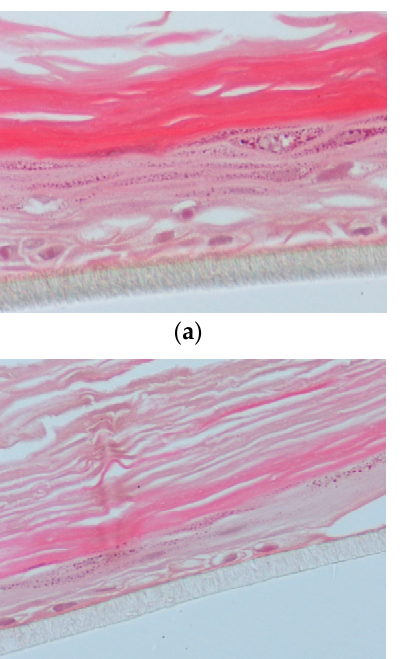
Figure 7. Propolis extracts decrease the mRNA levels of MMPs after UVB irradiation in a reconstituted human skin model. Epiderm TM EPI-200 human skin tissues were pretreated with 20 μ g/mL of either PR_1b ( a ) or PR_9b ( b ), for 2 h prior to UVB irradiation (55 mJ/cm 2 ) and incubated again with or without the propolis extracts for 2 h. After 24 h, the tissues were harvested, and total RNA was extracted. Quantitative real-time PCR was utilized to determine levels of MMP-1, -3, -7, and -9 mRNA. Expression levels of MMP-1, -3, -7, and -9 were normalized to those of β -actin . Untreated cells served as a reference sample. The formula RQ = 2 −ΔΔ Ct was used in order to quantitate the data. The graph is representative of three independent experiments performed in triplicate. * p ≤ 0.05, ** p ≤ 0.01, *** p ≤ 0.001, **** p ≤ 0.0001. To further validate the effect of propolis extracts on the UVB-induced overexpression of MMPs at protein level, immunohistochemical analysis was performed. As expected, UVB irradiation induced an upregulation of all the MMPs examined, especially MMP-3 and -9 (Figures 8B,F,J,N), compared to control (Figure 8A). In consistence with the real-time PCR data obtained from the skin